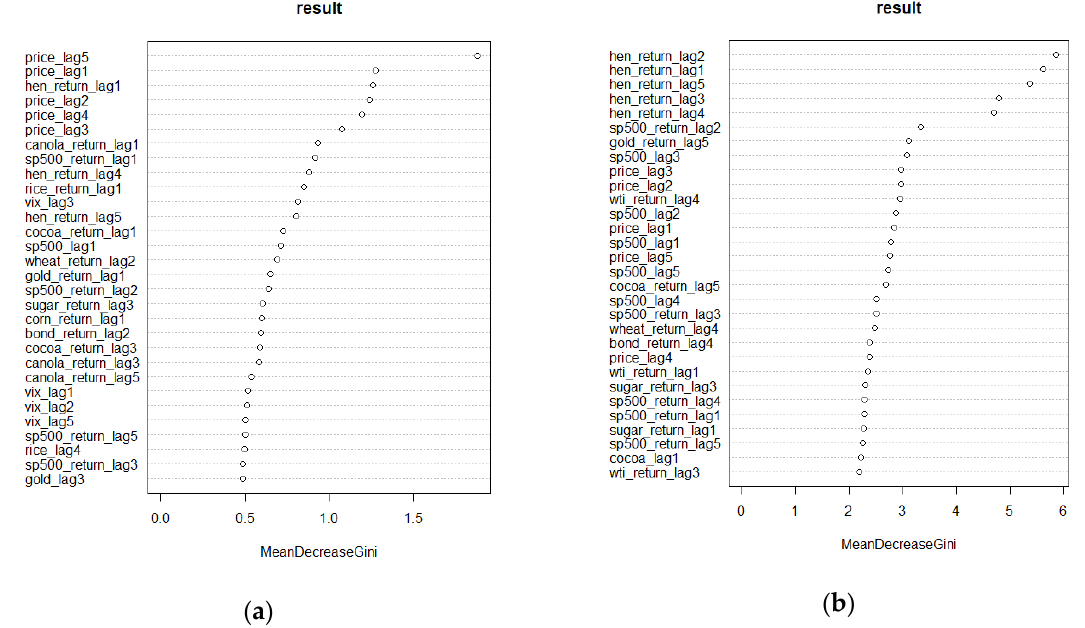
Figure A6. RF variable importance plots: all variables with the moving window and the expanding